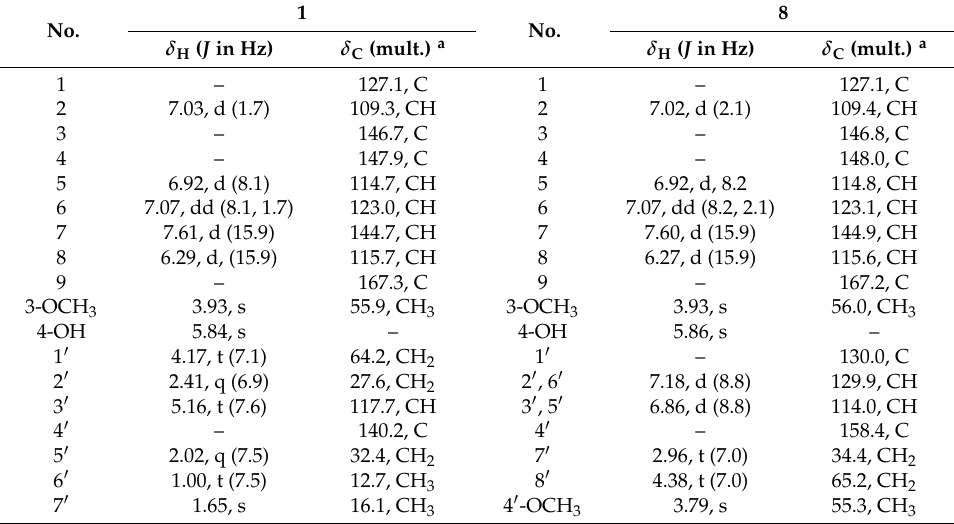
Table 1. 1 H (400 MHz) and 13 C (100 MHz)-NMR data for compounds 1 and 8 in CDCl 3 .